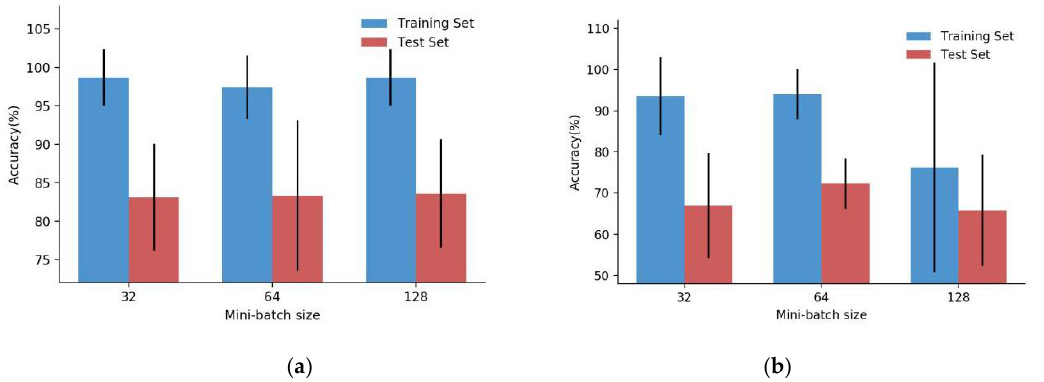
Figure 12. Comparison of accuracy with different mini-batch sizes by FCCDNNs. ( a ) C. elegans dataset, ( b ) zebrafish dataset.